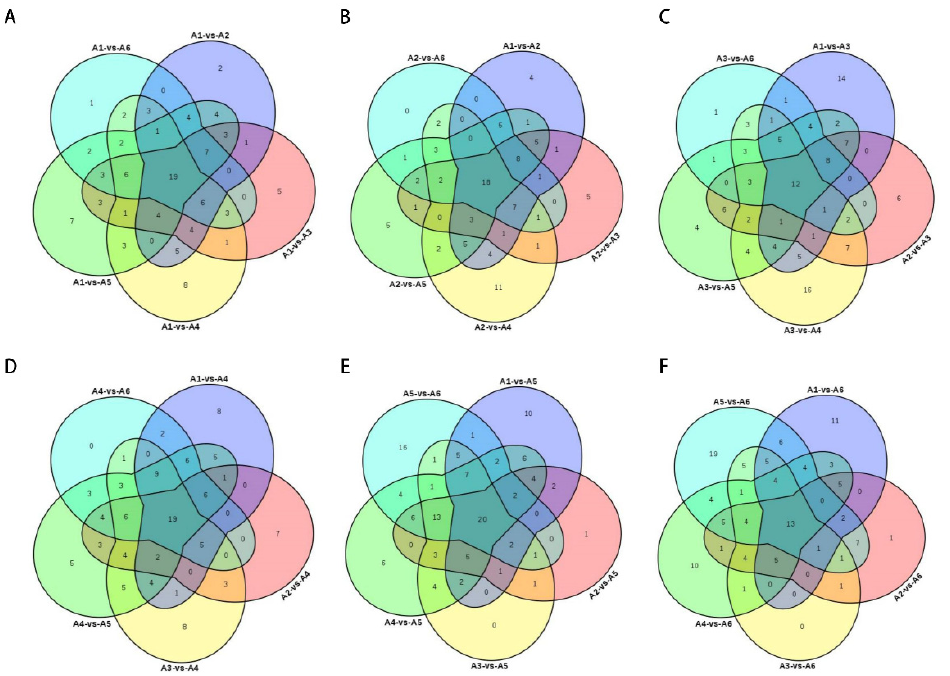
Figure 6. Venn diagram analysis of two-by-two differential metabolites with the other five groups, using groups A1, A2, A3, A4, A5, and A6 as core comparison groups, respectively. ( A ) Venn diagram analysis was performed with A1 as the core comparison group with the other 5 groups of differential metabolites. ( B ) Venn diagram analysis was performed with A2 as the core comparison group with the other 5 groups of differential metabolites. ( C ) Venn diagram analysis was performed with A3 as the core comparison group with the other 5 groups of differential metabolites. ( D ) Venn diagram analysis was performed with A4 as the core comparison group with the other 5 groups of differential metabolites. ( E ) Venn diagram analysis was performed with A5 as the core comparison group with the other 5 groups of differential metabolites. ( F ) Venn diagram analysis was performed with A6 as the core comparison group with the other 5 groups of differential